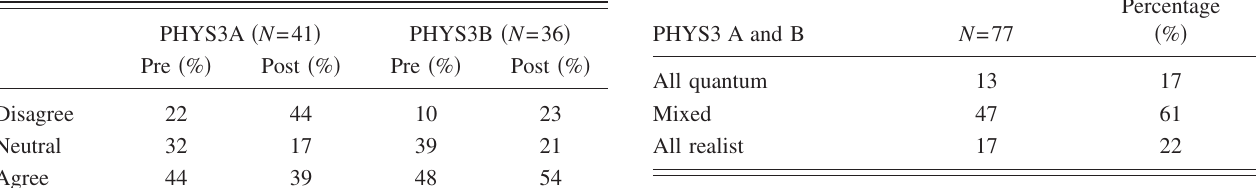
TABLE VII. Student responses to the statement “An electron in an atom has a definite but unknown position at each moment in time.”